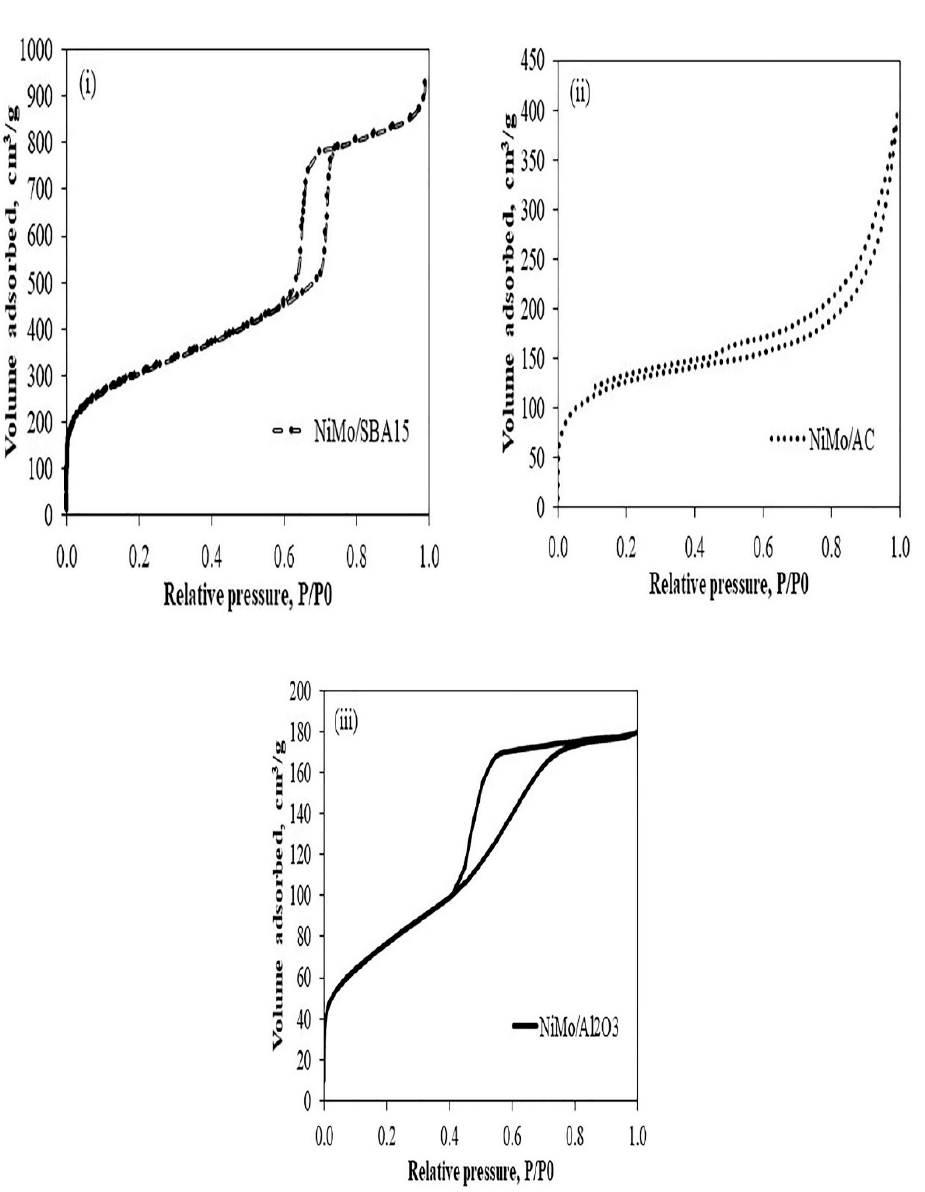
Figure 1. Nitrogen-sorption isotherms of the prepared NiMo catalysts: ( i ) NiMo/SBA15 catslyst, ( ii ) NiMo/AC catalyst, ( iii ) NiMo/Al2O3 catalyst.